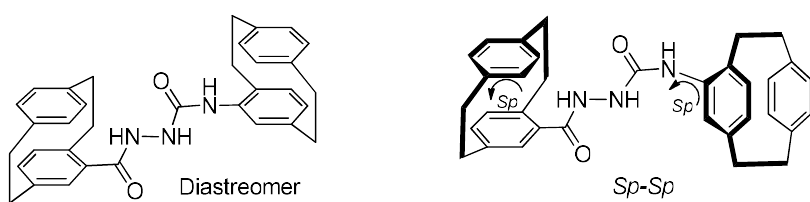
Figure 1. The structure of the diastereomeric and homochiral linked paracyclophanes such as N -5-(1,4(1,4)-dibenzenacyclohexaphane-1 2 -yl)carbamoyl)-5’-(1,4(1,4)-dibenzenacyclohexaphane-1 2 -yl carboxamide.